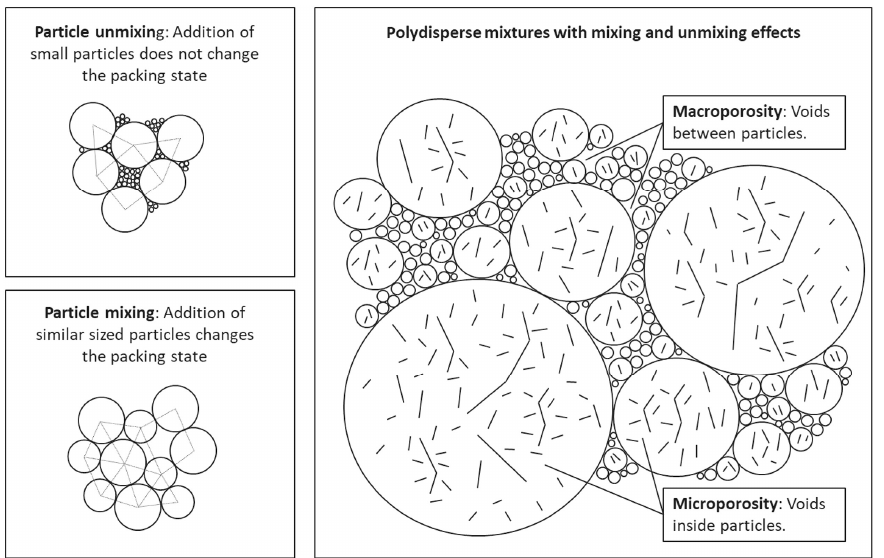
Figure 1. Porosity. ( Top left ): Illustration of particle unmixing for particles with strongly disparate diameters. As small particles are added to a system of larger particles, the larger particles resist being displaced and the packing state does not change. A similar effect occurs for the addition of very large particles. ( Bottom left ): Illustration of particle mixing for particles with similar diameters. As similar-sized particles are added to a system, particles can be displaced, thus changing the packing state. ( Right ): Illustration of the random packing structure of strongly polydisperse spheres. Compared to monodispersed configurations, porosity is reduced by the filling of void spaces. Macroporosity refers to the porosity generated by the void spaces between particles, whereas microporosity is caused by void spaces and cracks that formed inside individual particles.